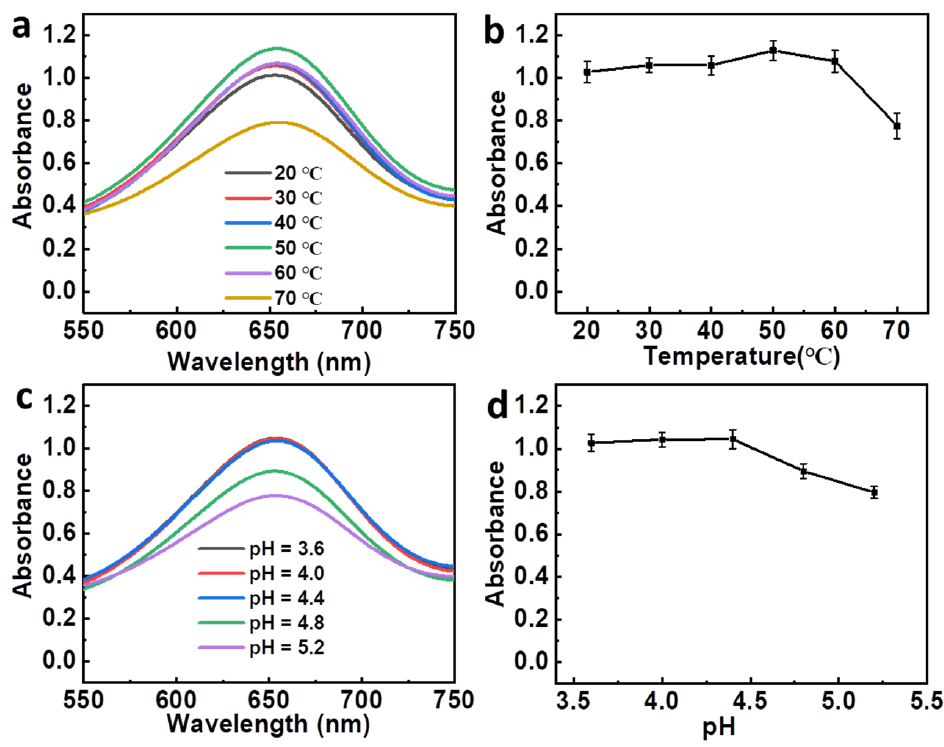
Figure 4. Effect of temperature ( a , b ) and pH ( c , d ) on the oxidase-like activity of Co 3 O 4 -200.